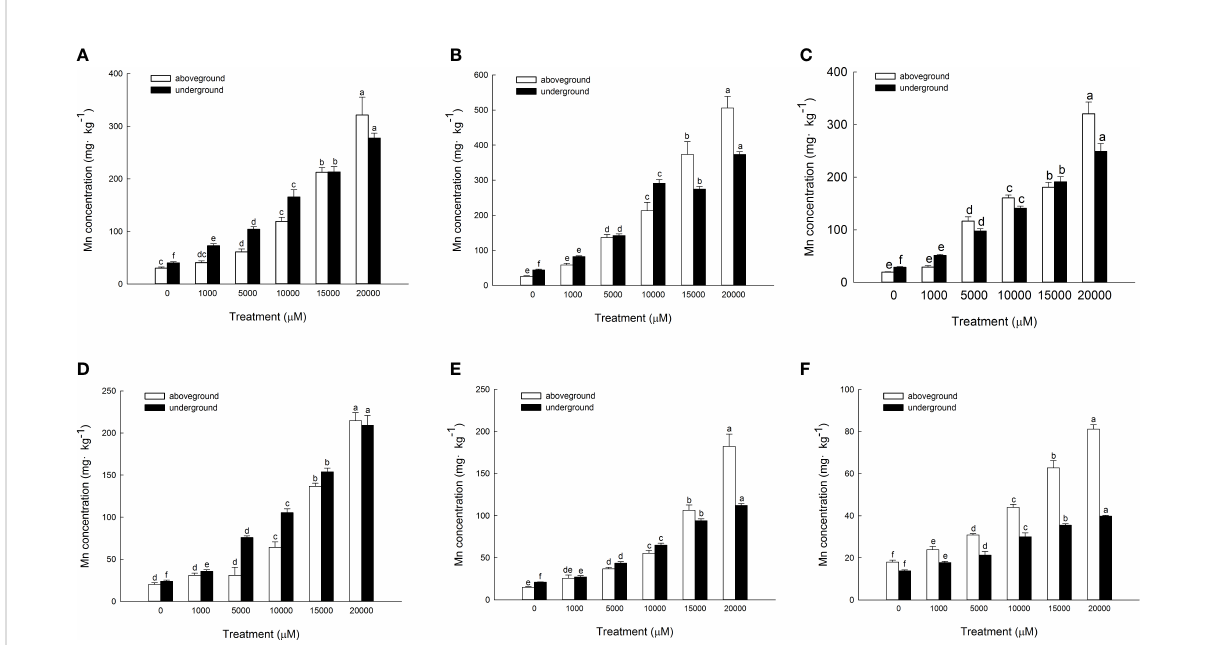
FIGURE 7 Concentrations of different Mn chemical forms in D carota aboveground and underground under Mn stress (mg kg -1 FW) [ (A) 80% ethanol; (B) deionized H 2 O; (C) 1 M NaCl; (D) 2% HAc; (E) 0.6 M HCl; (F) residue]. Data points and error bars represent mean and S.D. (n = 3). Values with different letters in the same parts of the plant indicate signi fi cant differences at the p < 0.05 level between different Mn concentrations according to the LSD test.